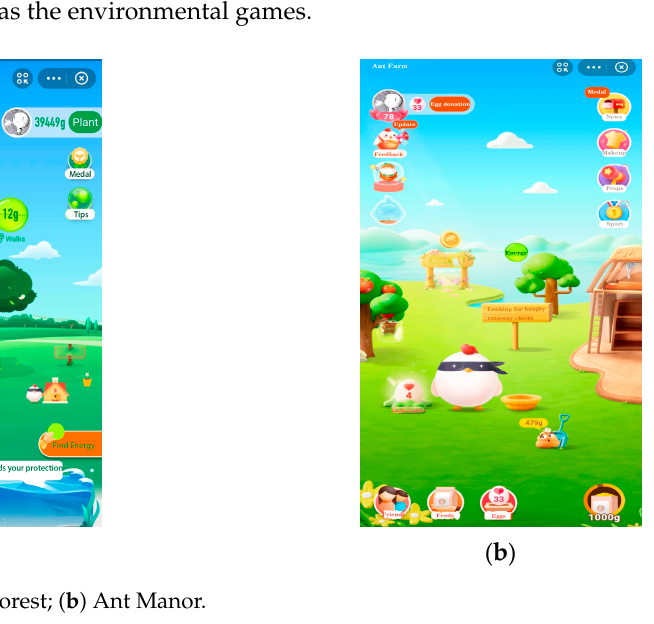
Figure 1. Concept model.